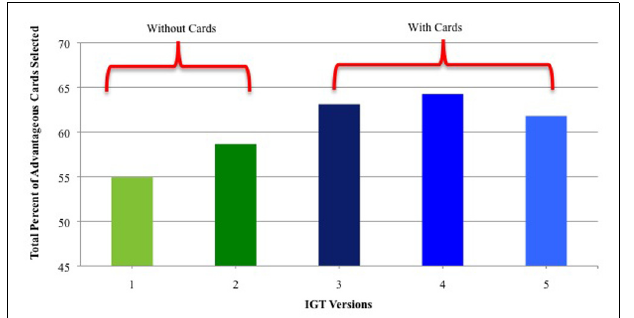
FIGURE 3 | Percent of advantageous card selections across four blocks of 25 IGT trials using real + virtual cards vs. virtual cards only.Vertical bars indicate